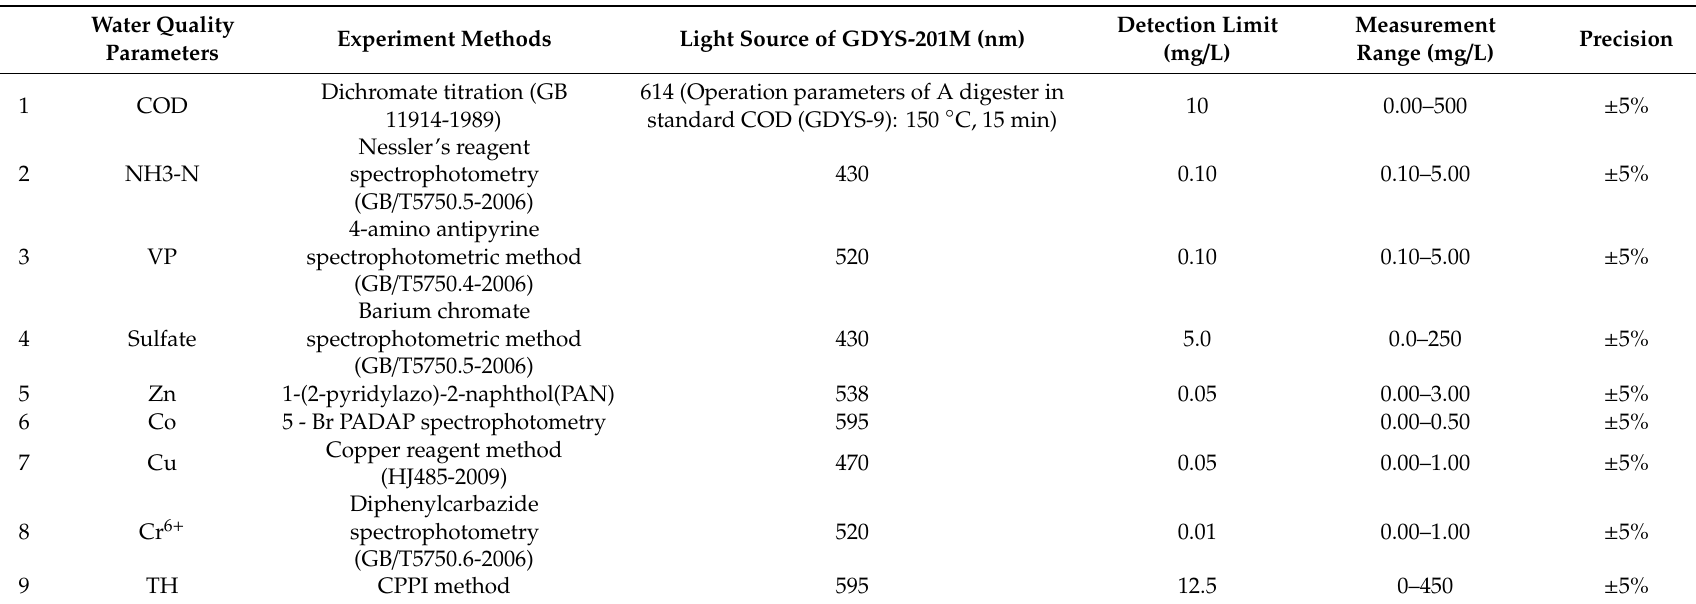
Table 2. Water indices and experimental methods. COD—chemical oxygen demand; VP—volatile phenol; TH—total